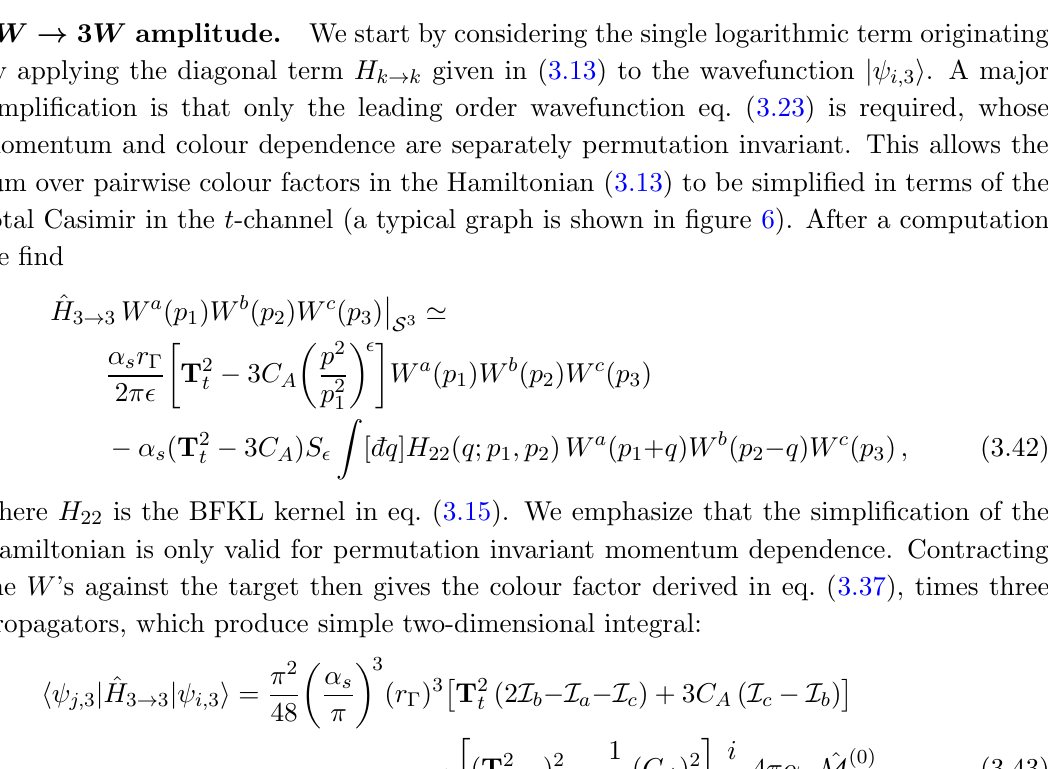
Figure 6 . Example of a diagram involved in the calculation of the three-Reggeon cut at three loops. This diagram, together with all the other diagrams obtained by inserting a rung in all possible ways between the three Reggeons, and considering all possible permutation of the three Reggeons themselves, arises from the insertion of a single factor of ^ H 3 ! 3 , as discussed below eq. (3.42). 3 W ! 3 W